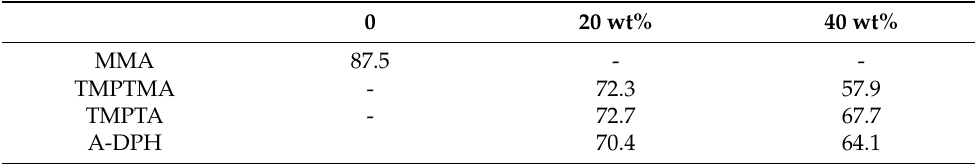
Table 3. Degree of Conversion